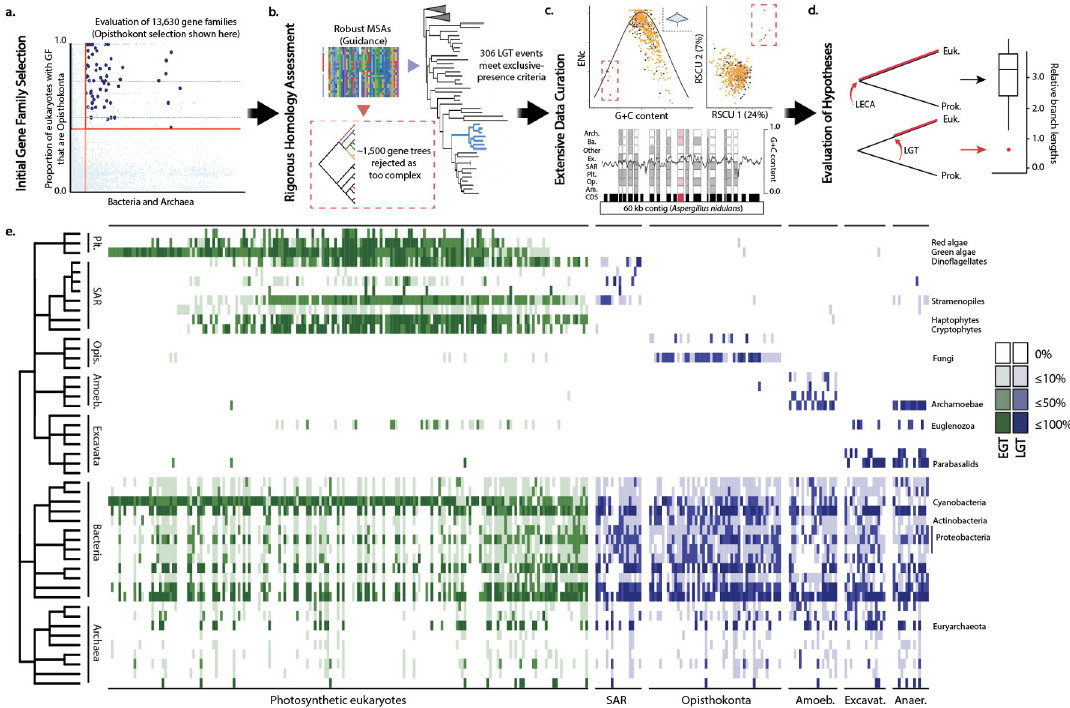
Fig 1. Rigorous methodology for LGT identification, curation and analysis uncovers 306 interdomain LGT events. (A) Using our taxon-rich phylogenomic pipeline PhyloToL, we initially identified 1,738 gene families as potential interdomain EGT/LGTs based on both the proportion of eukaryotes initially assigned to each GF that are of the target recipient clade (y axis) and number of prokaryotic sequences (x axis). (B) We used Guidance to assess homology and evaluated tree topologies for all candidate LTGs. (C) We curated sequences by analyzing patterns of compositional bias and codon usage for transcriptomic data (top) and by retaining only robustly- mapped sequences for genomic data (bottom). (D) To test the alternative hypothesis of differential gene loss, we analyzed relative branch lengths between putative recipients and donors. (E) Candidate LTGs exhibit exclusive presence in prokaryotes and ‘recipient’ eukaryotes; each column represents an interdomain transfer event. Eukaryotes (top) are shaded by the proportion of the taxa in the subclade (row) that appear in the tree, and prokaryotes (bottom) are shaded by the proportion of prokaryotes in the tree that are of the subclade. Abbreviations are as follows: Plt: Archaeplastida; SAR: Stramenopila, Alveolata, and Rhizaria; Opis: Opisthokonta; Amoeb: Amoebozoa; Excavat: Excavata; Anaer: